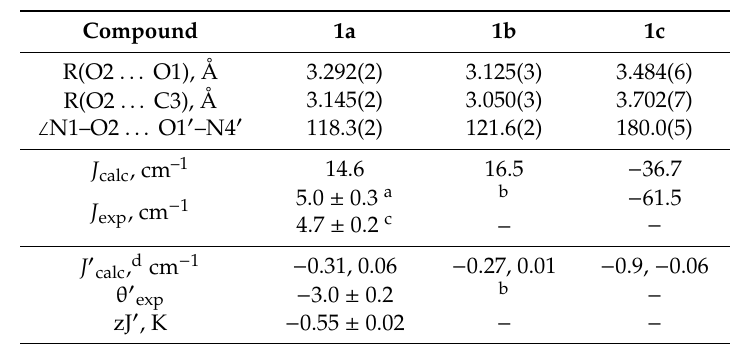
Table 2. Contacts O ... O and O ... C3, and the dihedral angles for the neighboring pairs of radicals, calculated values of exchange interaction parameters ( J calc ) as well as values corresponding to the best fit of experimental temperature dependences of molar magnetic susceptibility for compounds 1a,b (this study) and 1c